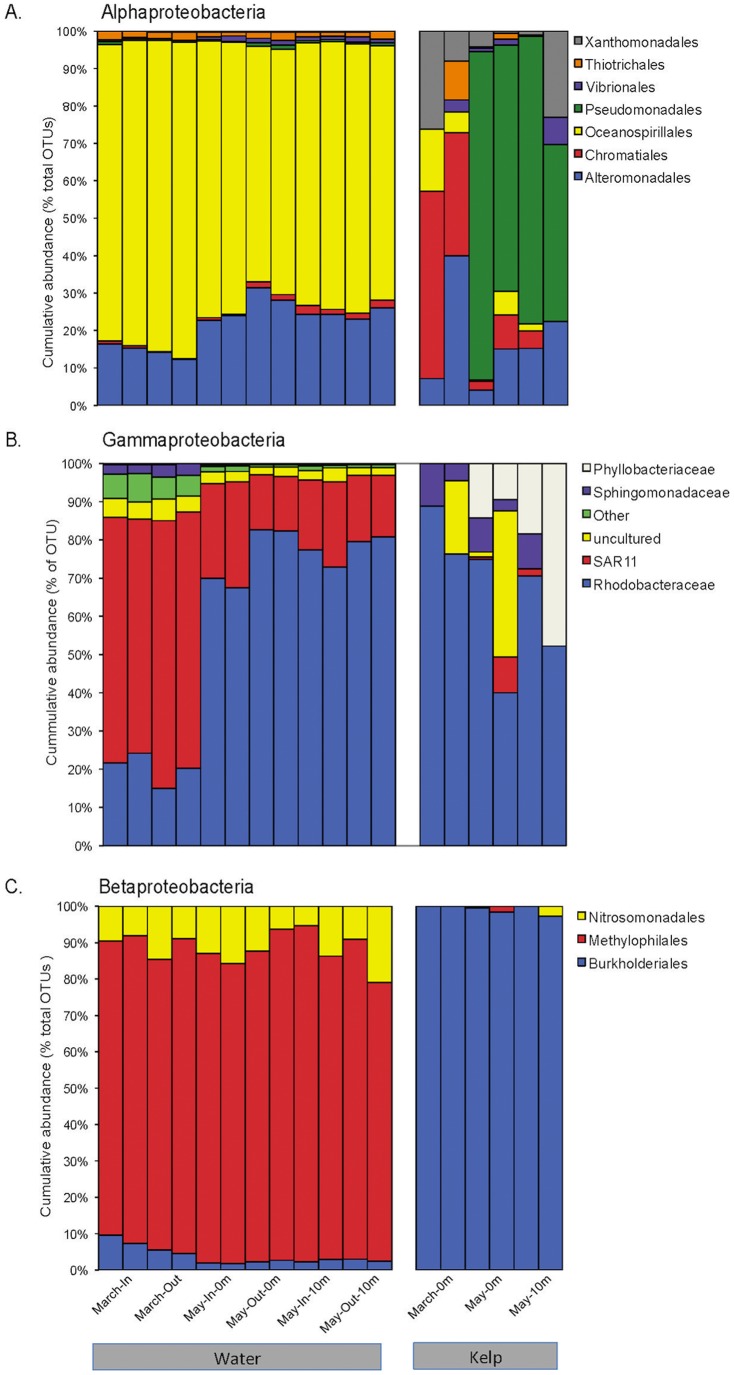
Bacterial distribution of the most abundant groups within the predominant classes of the Proteobacterial phylum.The Alpha- (A), Gamma- (B) and Betaproteobacteria (C) were consistently present in high abundances in all of the samples. A further evaluation within these classes showed differences in the profiles and abundance of the bacterial groups in seawater and on the kelp surface. X-axis sample designation is the same as Figure 1.